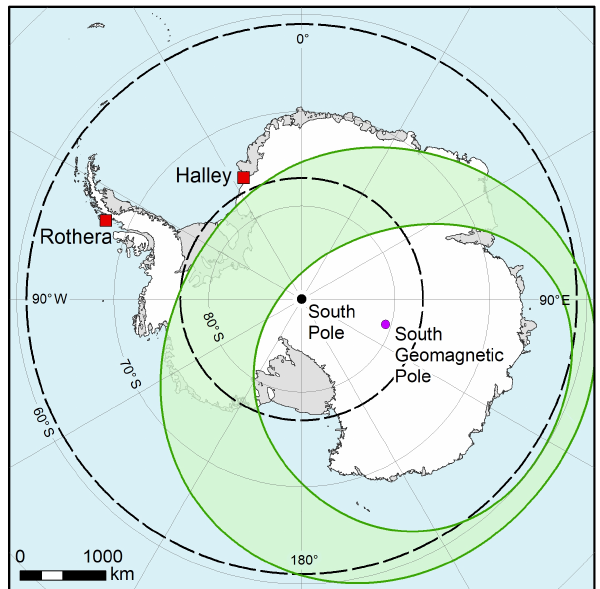
Figure 1. Location of the two MF radars used in this study (Halley and Rothera) marked as red squares, with the locations of the geo- centric (black) and geomagnetic (purple) south poles. The dashed black lines give estimates of the extent of the polar vortex from May (inner) to August (outer) (from Zhang et al., 2017). The green- shaded region shows the statistical location of the auroral oval for quiet geomagnetic activity (Holzworth and Meng,